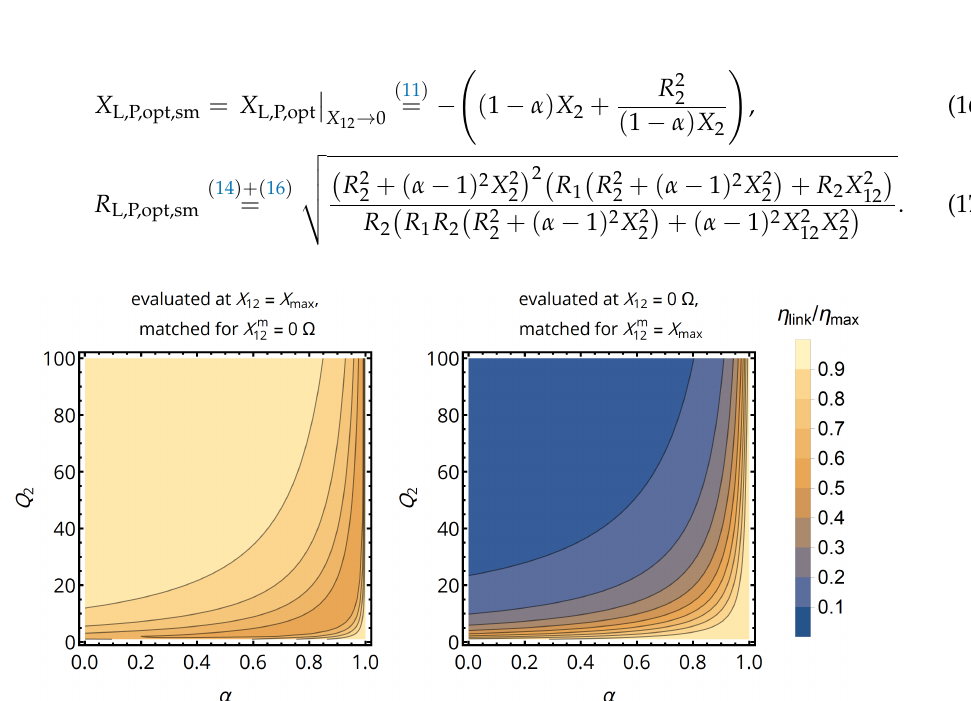
Figure 3. Normalized efficiency as a metric of performance degradation when matching the coil system for a nominal mutual impedance X m , but operating it at a different configuration X 12 . 12 Matching the system for a small nominal mutual impedance does barely reduce efficiency for α < 0.8 and higher values of Q 2 . For all graphs, we assumed Q 1 =